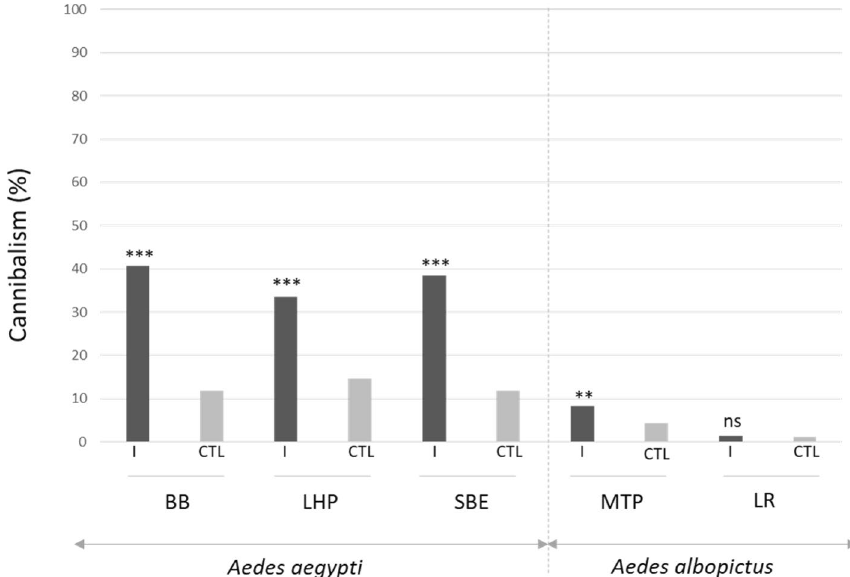
Figure 3. Larval cannibalism rate on day 25 after AalDV2 infection of first instar mosquito larvae for the different strains tested of Ae. albopictus (MTP, Montpellier and LR, La Réunion) and Ae . aegypti (LHP, Long- Hoà, BB, Bora-Bora and SBE, Benin). Larvae (N = 3 replicates of 150 larvae per experimental condition) were infected or not, with 3 × 10 11 veg/ml of AalDV2. Binomial linear mixed effect models were used to compared the impact of AalDV2 on cannibalism in infected groups (I) compared control groups (CTL). ***p-value < 0.001; **p-value < 0.01; n.s., not statistically significant.